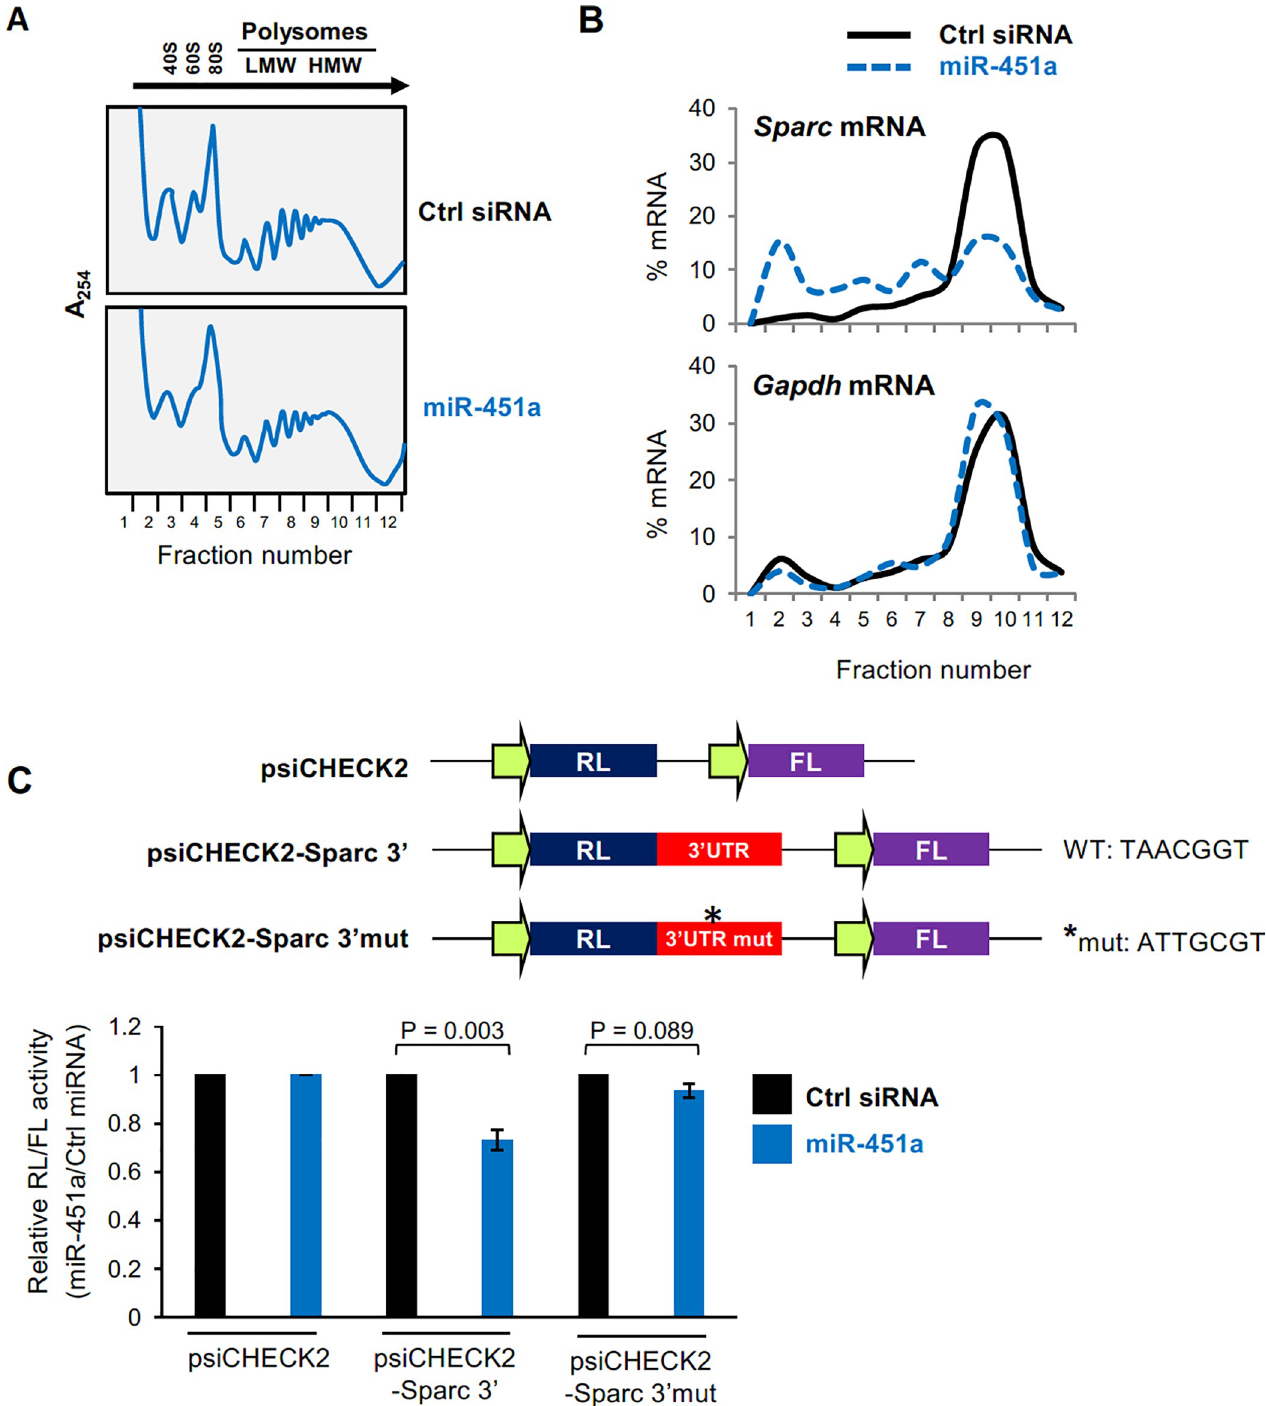
Fig 3. miR-451a inhibits translation of Sparc mRNA. (A) Global polysome profile of C2C12 cells 48 h after transfection either with Ctrl siRNA or miR-451. (B) The relative distribution of Sparc mRNA (and housekeeping gene Gapdh mRNA) was studied by RT-qPCR analysis of RNA in each of 12 polysome fractions. (C) Top , schematic of the dual-luciferase reporter plasmids psiCHECK2, the control vector expressing renilla luciferase (RL) and the internal control firefly luciferase (FL); the test vector psiCHECK2-Sparc-3 0 contains the Sparc 3 0 UTR downstream of the RL coding region and the psiCHECK2-Sparc-3 0 -Mut contains the Sparc 3 0 UTR downstream of the RL coding region with mutated target site for miR-451a. Bottom , C2C12 cells were transfected with either miR- 451a or Ctrl siRNA and either psiCHECK2, psiCHECK2-Sparc 3’ or psiCHECK2-Sparc 3’mut; the ratio of RL activity to FL activity was calculated 16 h after transfection. The relative RL/FL ratios of miR-451a-transfected cells relative to RL/FL of Ctrl siRNA-transfected cells are indicated. Data represent the means ± SEM from 3 independent experiments. Significance (P) is indicated.